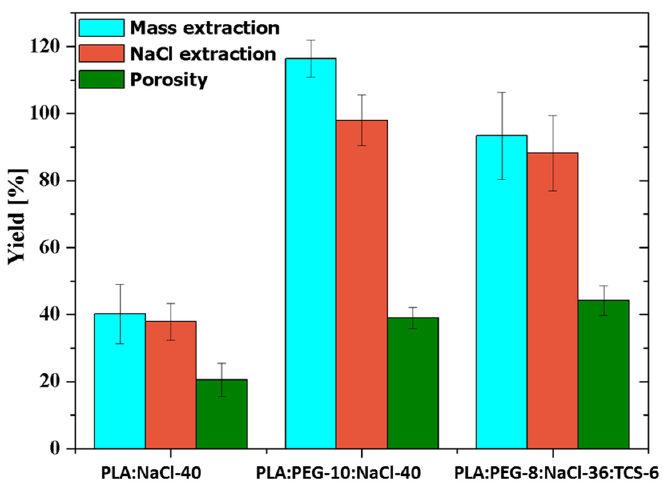
Figure 13. Extraction yields and porosity for PLA:NaCl-40, PLA:PEG-10:NaCl-40, and PLA:PEG-8:NaCl-36:TCS-6.